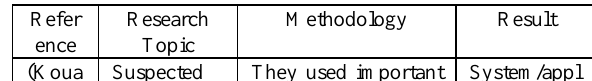
Table 4. SWRL rules for recommending Covid-19 treatment